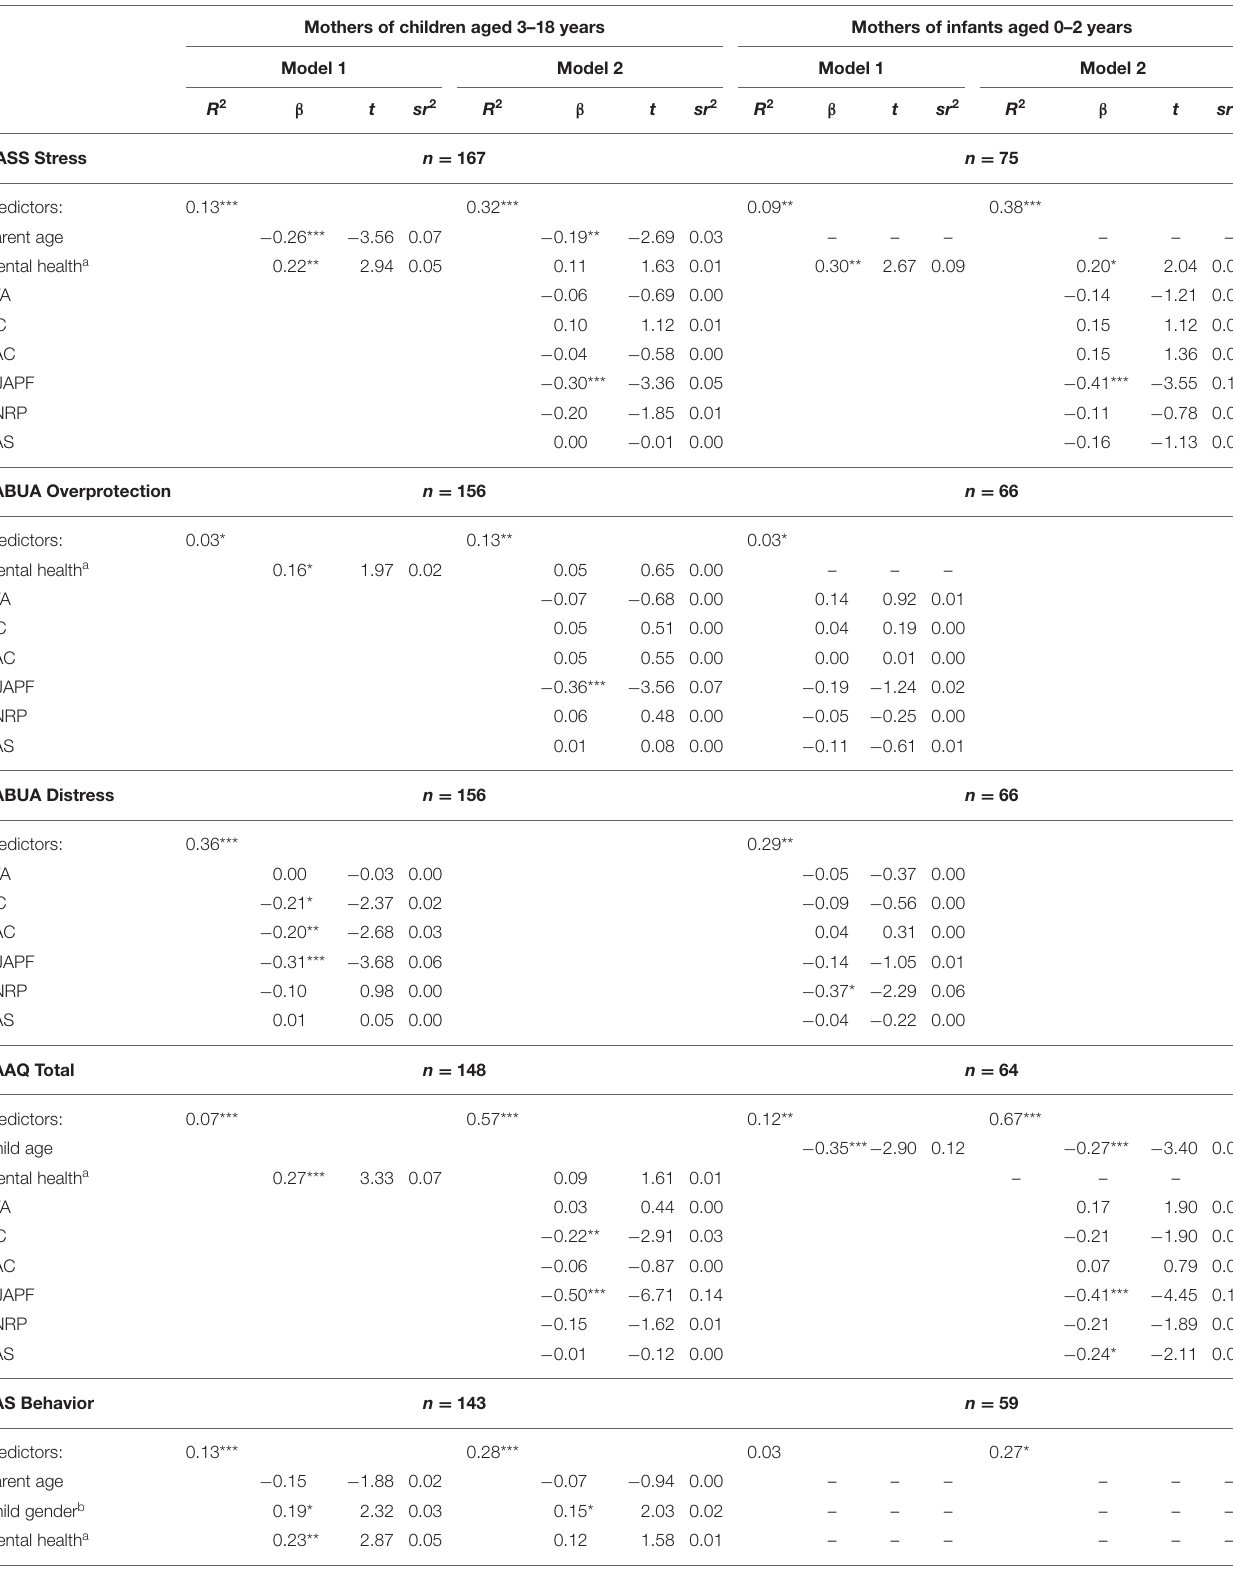
TABLE 7 | Regression analyses of mindful parenting scale predictors of parent outcome variables, for mothers of infants and